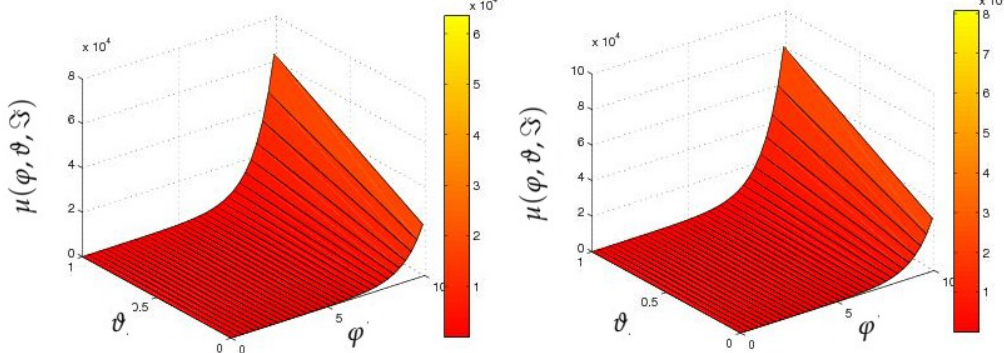
Figure 4. The HPTM graphs of δ = 0.6 and 0.4 of µ ( ϕ , ϑ ) , Example